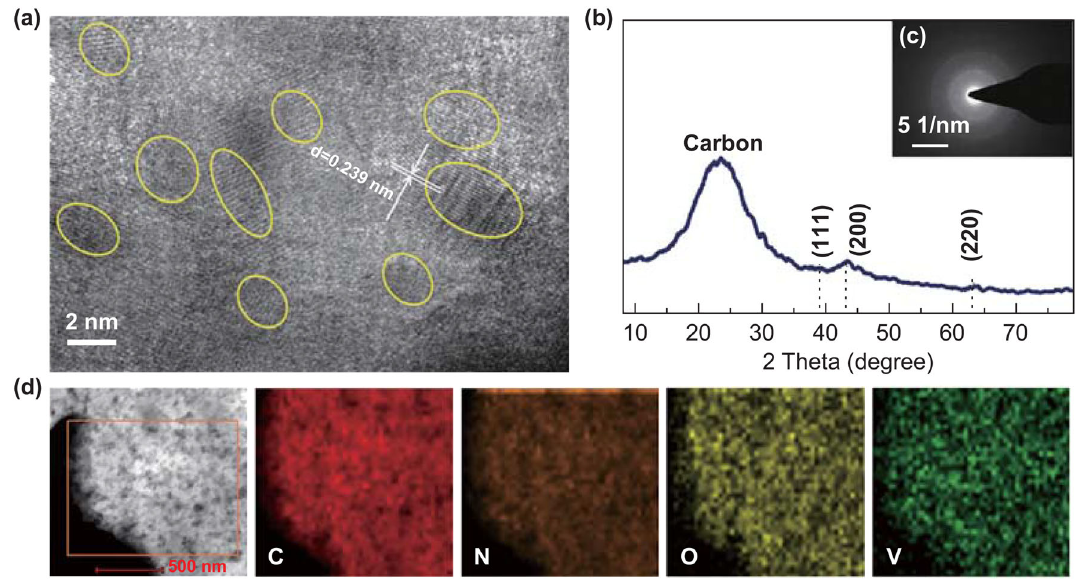
Fig. 2 a HRTEM image, b XRD pattern, c selected-area electron diffraction, and d TEM elemental mapping images of the VN/C (I)